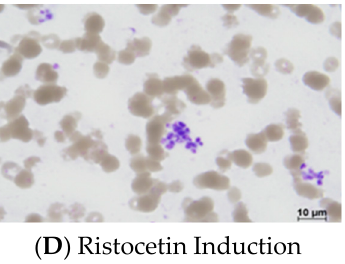
Figure 2. Effects of platelet lysate on platelet aggregation in direct mixing of platelet lysate with whole blood. Percentage changes in platelet concentrations ( A ) and large cell ratio of platelet ( B ) affected by platelet lysate of different concentrations. Platelet lysate- ( C ) and ristocetin- ( D ) induced platelet aggregation in platelet-rich plasma. ( E ) Number of platelets per aggregate induced by different concentrations of platelet lysate. Controls, sample size, statistical analysis and abbreviations used are as described in the legend to Figure 1. * p < 0.05 versus the saline 50% group in the Student’s t- tests. Table 2. Changes in platelet concentration, platelet large cell ratio, and platelet per aggregate in different constituents of platelet lysate and whole blood.